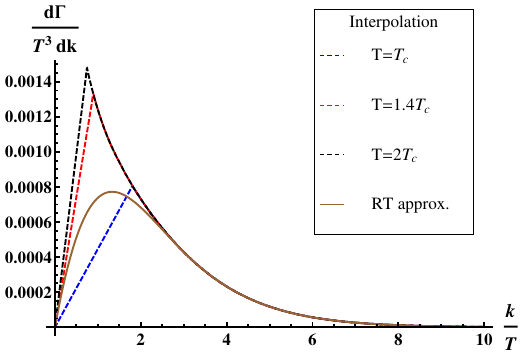
Figure 10 . Thermal-photon emission rates Figure 11 . Photo-emission rates from the RT approximation with di(cid:11)erent couplings (relax- ation